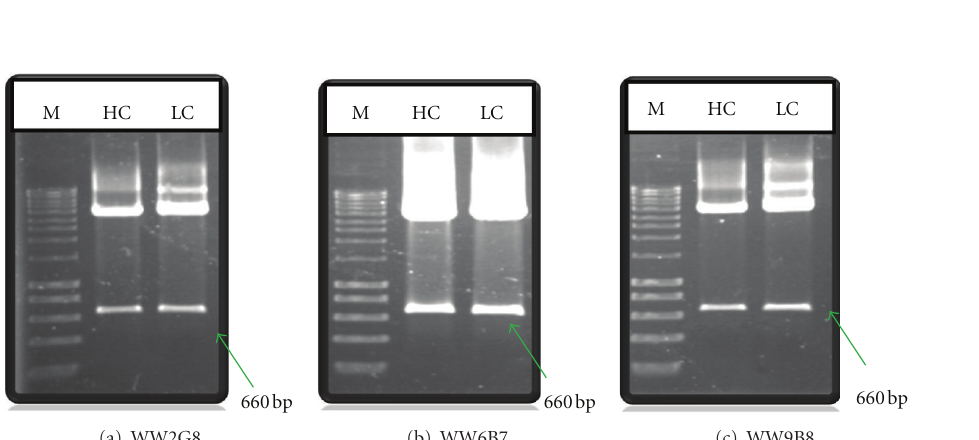
Figure 1: Cloning of heavy and light chains into phagemids. Xho I/ Spe I restricted heavy chain and Xba I/ Sac I restricted light chain inserted products of (a) WW2G8, (b) WW6B7, and (c) WW9B8 from phagemids were shown. The inserts of 660 bp were obtained for both heavy and light chains. (HC: heavy chain, LC: light chain, M: DNA